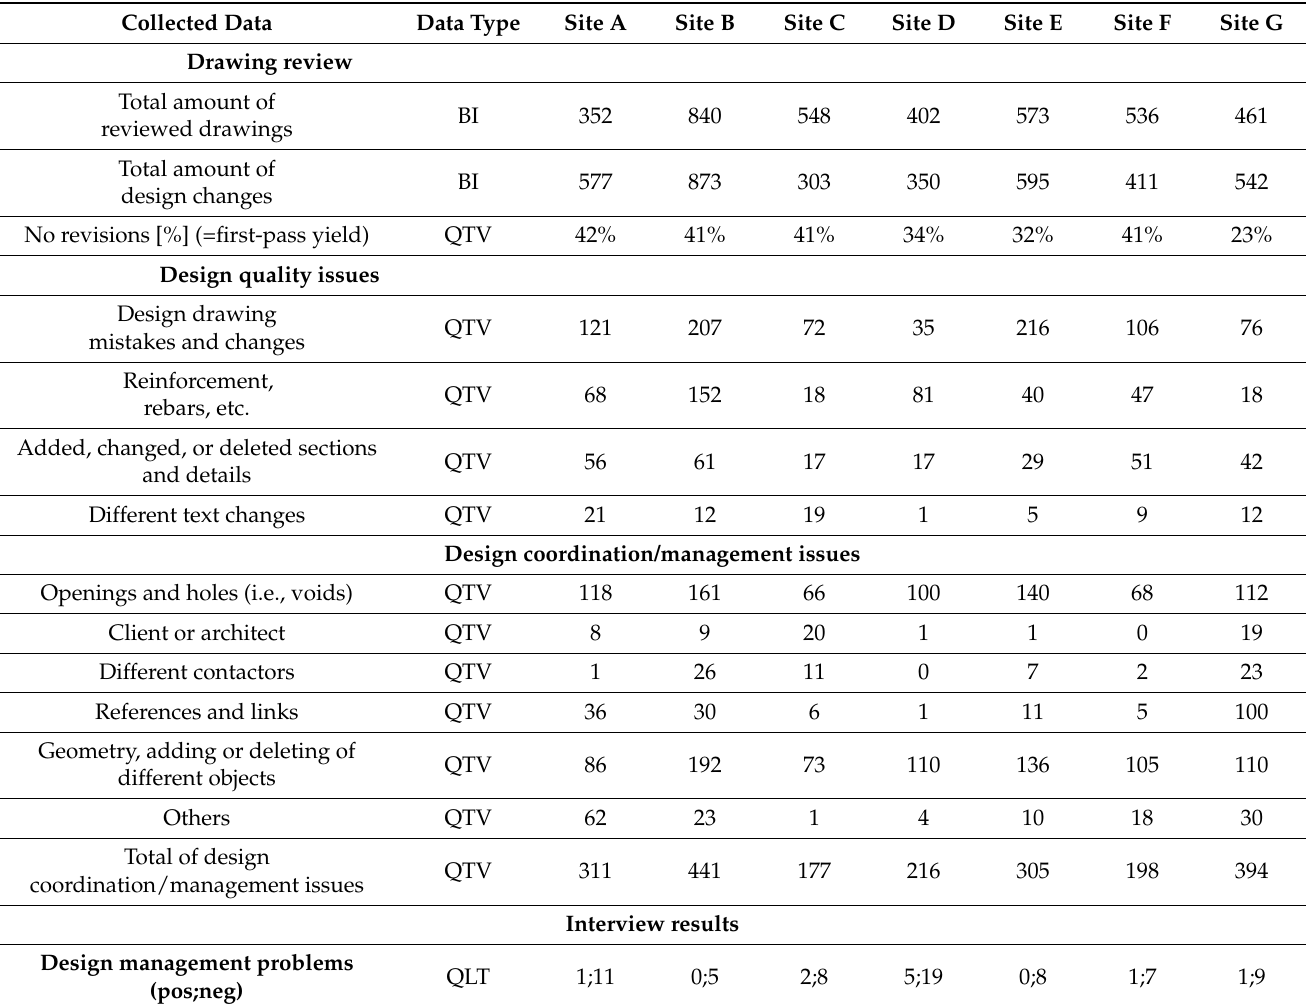
Table 2. Summary table of design quality—drawing review. Abbreviations: Background information = BI; Quantitative = QTV; Qualitative =